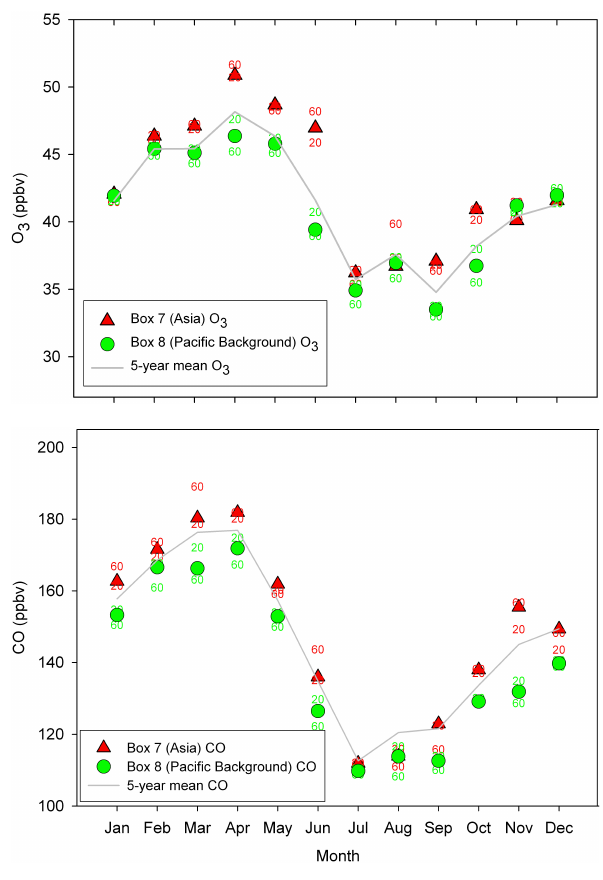
Fig. 7. (a) Mean values of O 3 associated with transport through Boxes 7 and 8 as a function of month of year. Boxes are assigned based on 40% of the seasonally varying maximum time in a box. For comparison, mean values for 20% and 60% of time in a box are also shown. (b) As in (a) but for